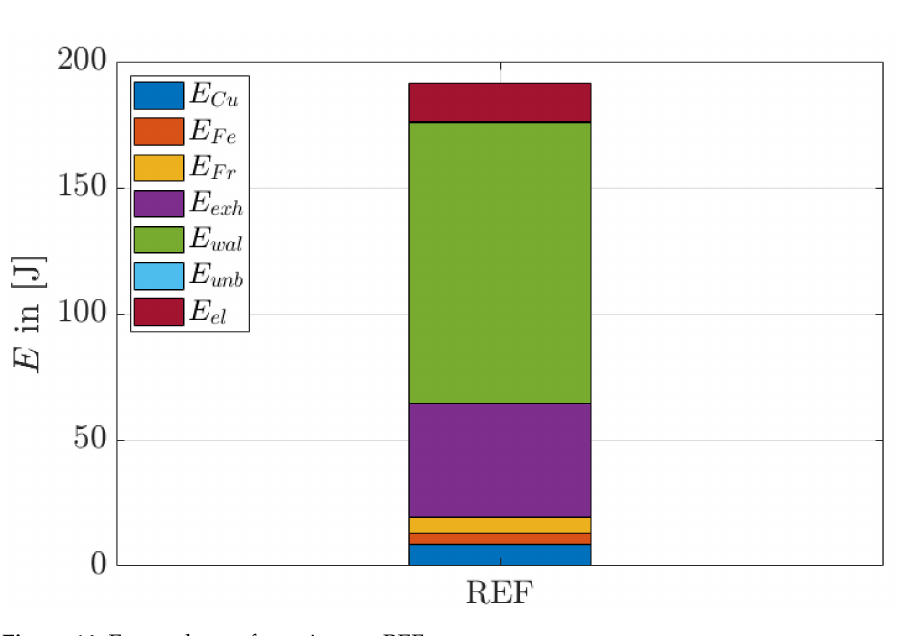
and ω = 80 rad/s, s . s